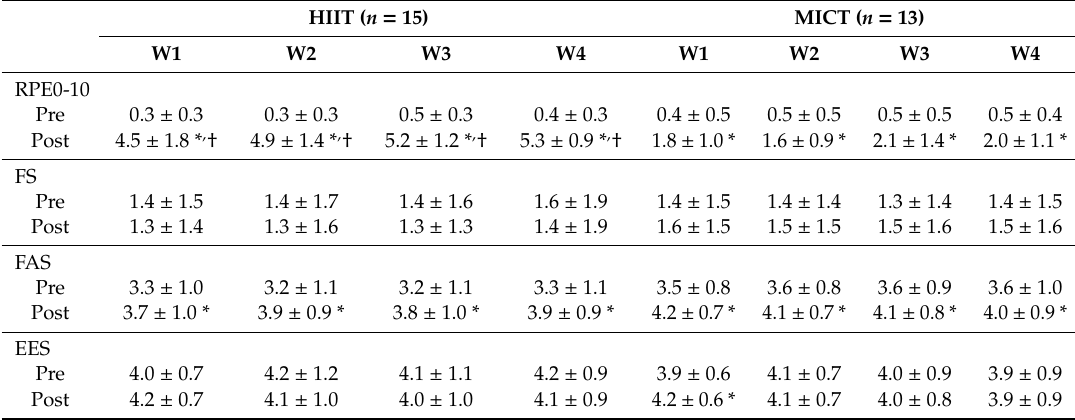
Table 4. Changes in a ff ect and enjoyment during 4-week exercise